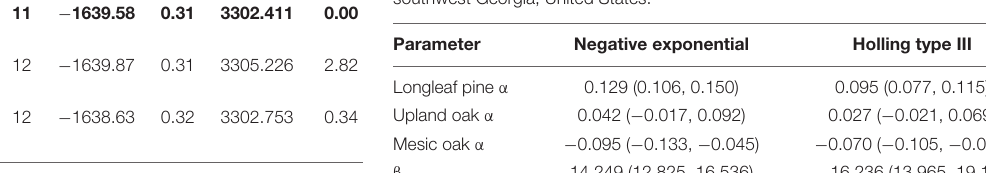
TABLE 6 | Parameter estimates ( ± 2 AIC c unit support limits) for negative exponential and Holling type III models of the effects of the proximity of three guilds of trees on FRED during prescribed fires in longleaf pine woodlands in southwest Georgia, United